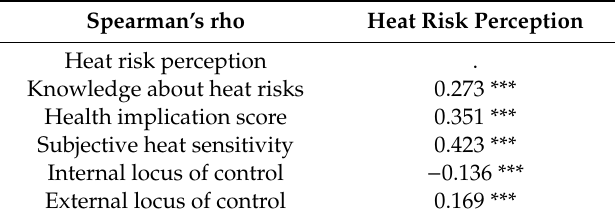
Table 3. Spearman’s correlation for heat risk perception.